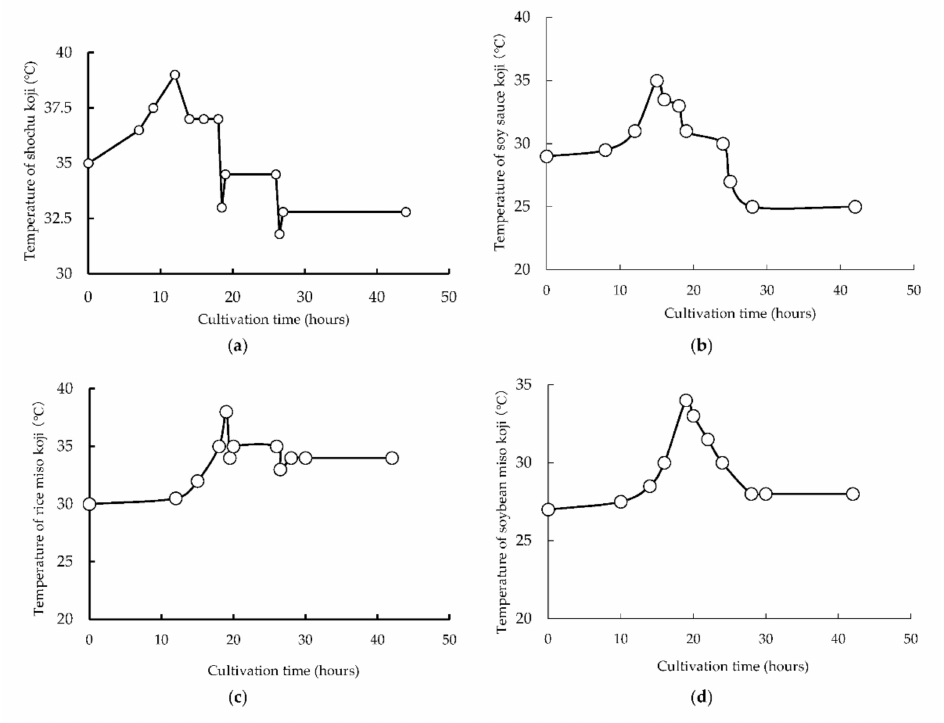
Figure 7. Production process (- -) of koji suitable for each fermented food example: ( a ) shochu; (cid:35) ( b ) soy sauce; ( c ) rice miso; ( d ) soybean